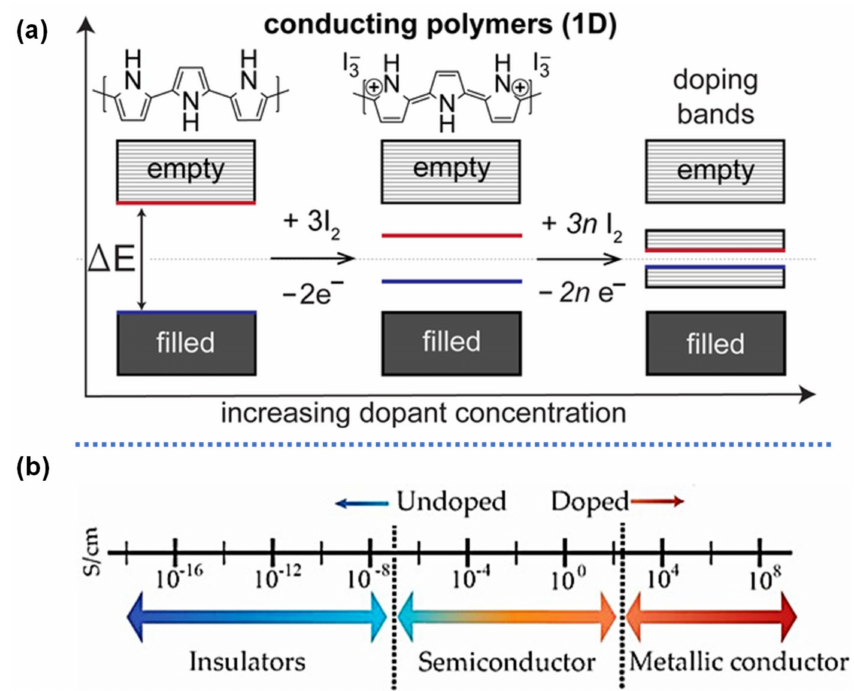
Figure 2. Schematic of ( a ) molecular orbital of conducting polymers during p-doping and n-doping (example of PPy), and ( b ) range of conductivities for CPs in their doped and undoped forms, reproduced with permission from Refs.